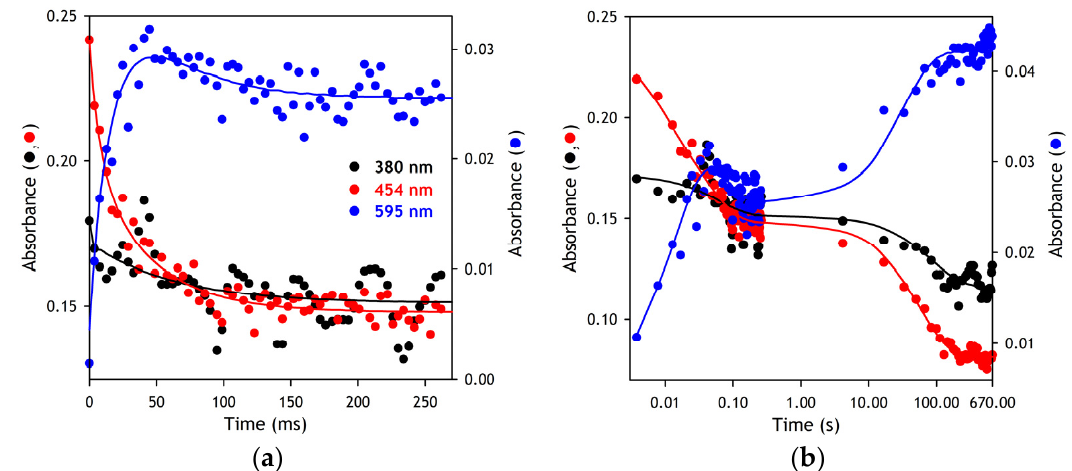
Figure 3. Changes in absorbance of SbCPR at 380, 454, and 595 nm in the process of its NADPH-dependent reduction. Panel ( a ) shows the initial parts of the curves in linear coordinates. In panel ( b ), the same datasets are plotted versus the logarithm of time in the entire time range of the experiment. Solid lines correspond to the approximations of the kinetic curves with the three-exponential equation.